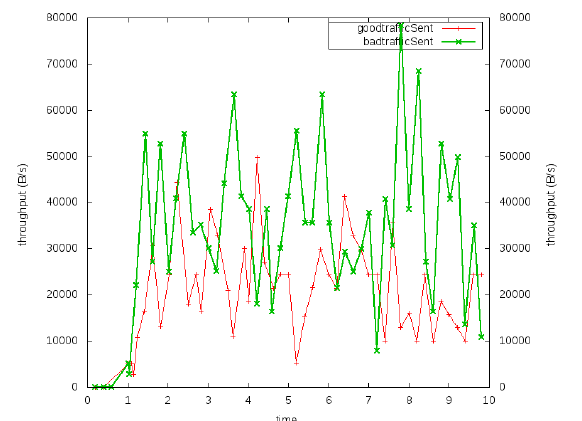
Fig. 3. Selected traffic flows plotted, when the firewall is not active